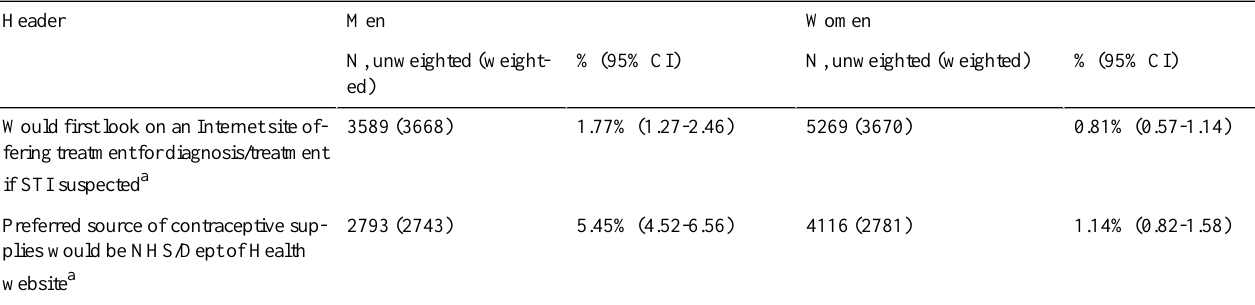
Table 5. Preference for Internet sources of diagnosis/treatment of sexually transmitted infections and condoms/contraception.